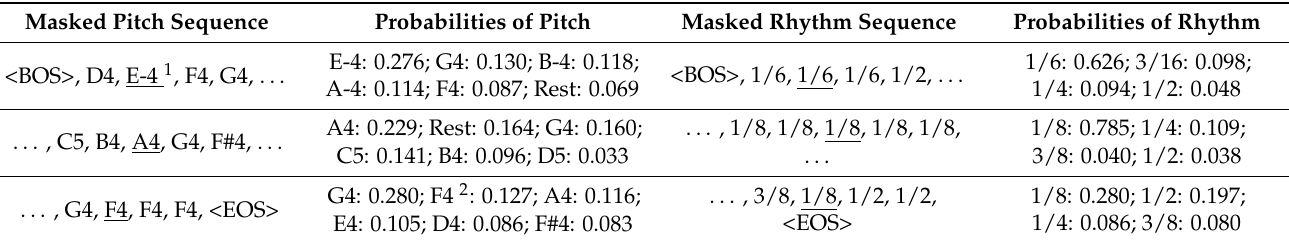
Table 4. Details of conditional generation.